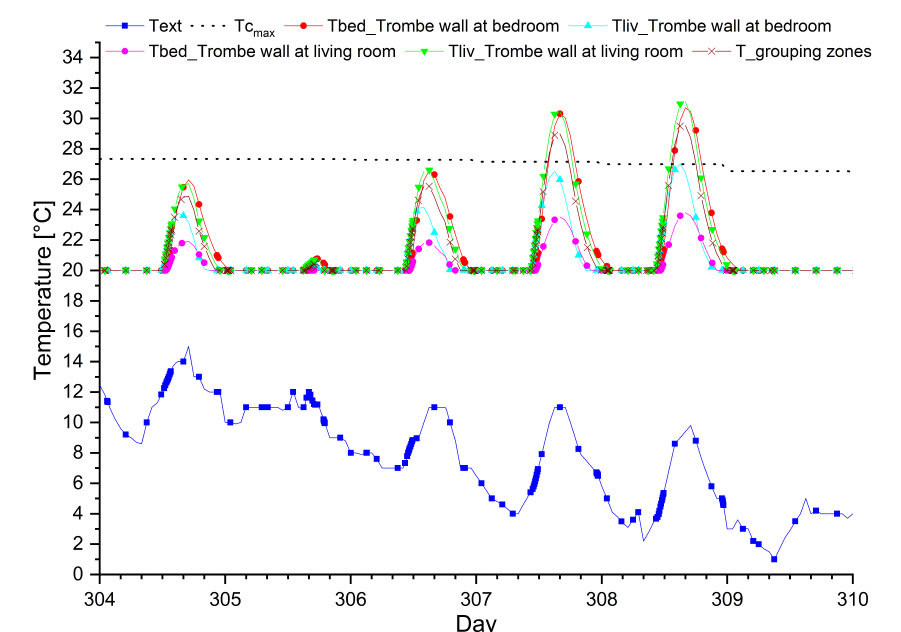
Figure 24. Temperature discomfort in the bedroom and living room relative to changes in the position of the solar Trombe wall, and temperature discomfort in the grouped zones. T ext denotes the outdoor air temperature; Tc max denotes the setpoint comfort temperature. Table 12. Number of hours of temperature discomfort in the bedroom, living room and grouped thermal zones during the one-year heating period. Bedroom Equipped with Living Room Equipped Grouped Zones a Solar Trombe Wall with a Solar Trombe Wall with a Solar Trombe Wall Bedroom Living